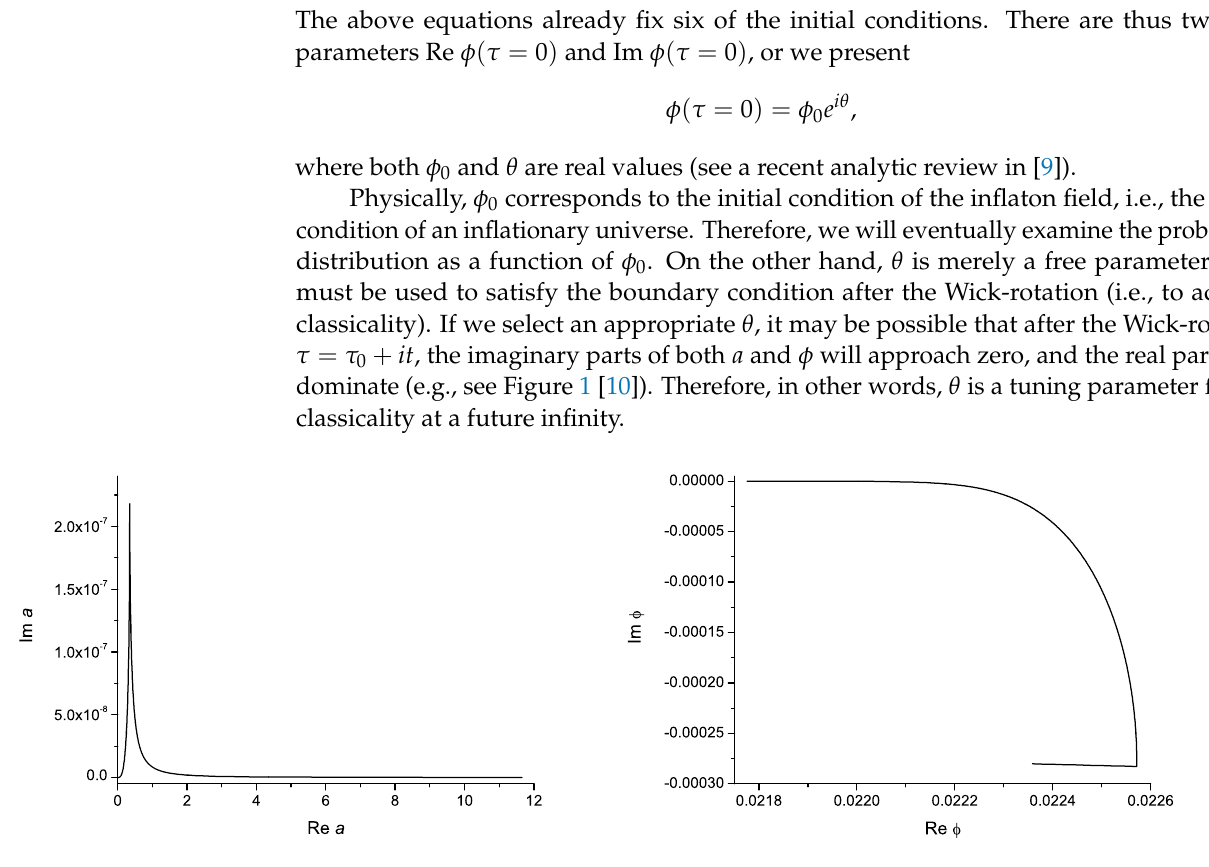
Figure 1. Example of a fuzzy instanton solution with m 2 / V 0 = 0.2 and m φ 0 / and the right side is the scalar field φ . Here, the cusp is the turning point from a Euclidean to a Lorentizan signature